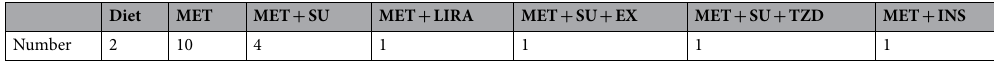
Table 2. Preoperative antiglycemic treatment in patients with type 2 diabetes. MET = Metformin, SU = Sulfonylurea, LIRA = Liraglutide, EX = Exenatide, TZD = Glitazone, INS = Insulin.